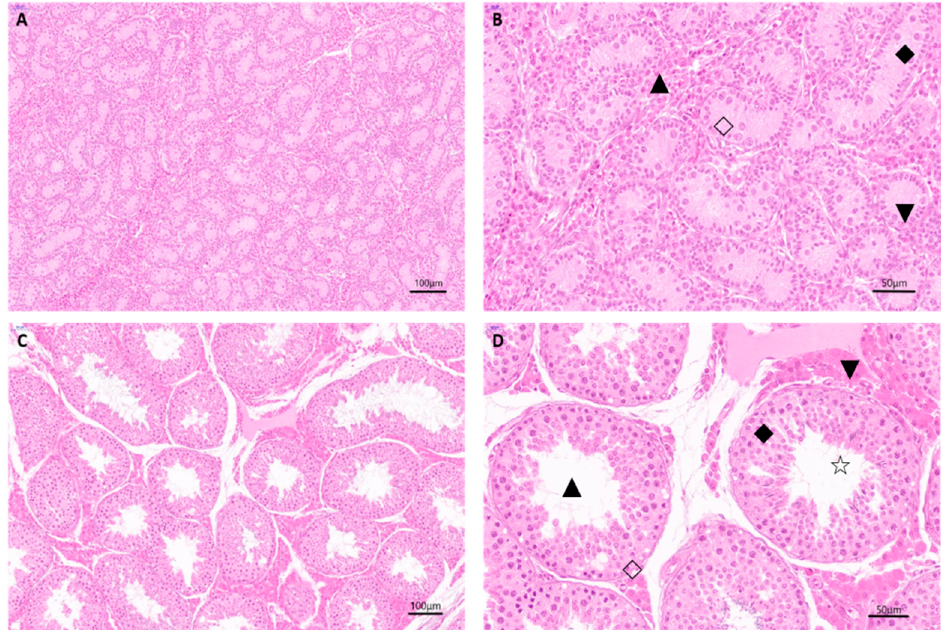
Figure 1. Morphological and histological analysis of the testes tissues of young (Piglet-D30) and sexually mature (Adult-D210) boars. Different magnifications of young boar testis tissues ( A , B ). The seminiferous tubule structure is formed, the lumina are in an atresia state, and it contains only one type of germ cell, namely the spermatogonia. Bars = 100 μ m and 50 μ m. Different magnifications of mature boar testis tissues ( C , D ). The seminiferous tubules have clear lumina and contain germ cells at different periods. Bars = 100 μ m and 50 μ m. ▲ Seminiferous tubule; ▼ interstitial cells; ◆ spermatogonia cells; ◇ sustentacular cells; ☆ sperm.